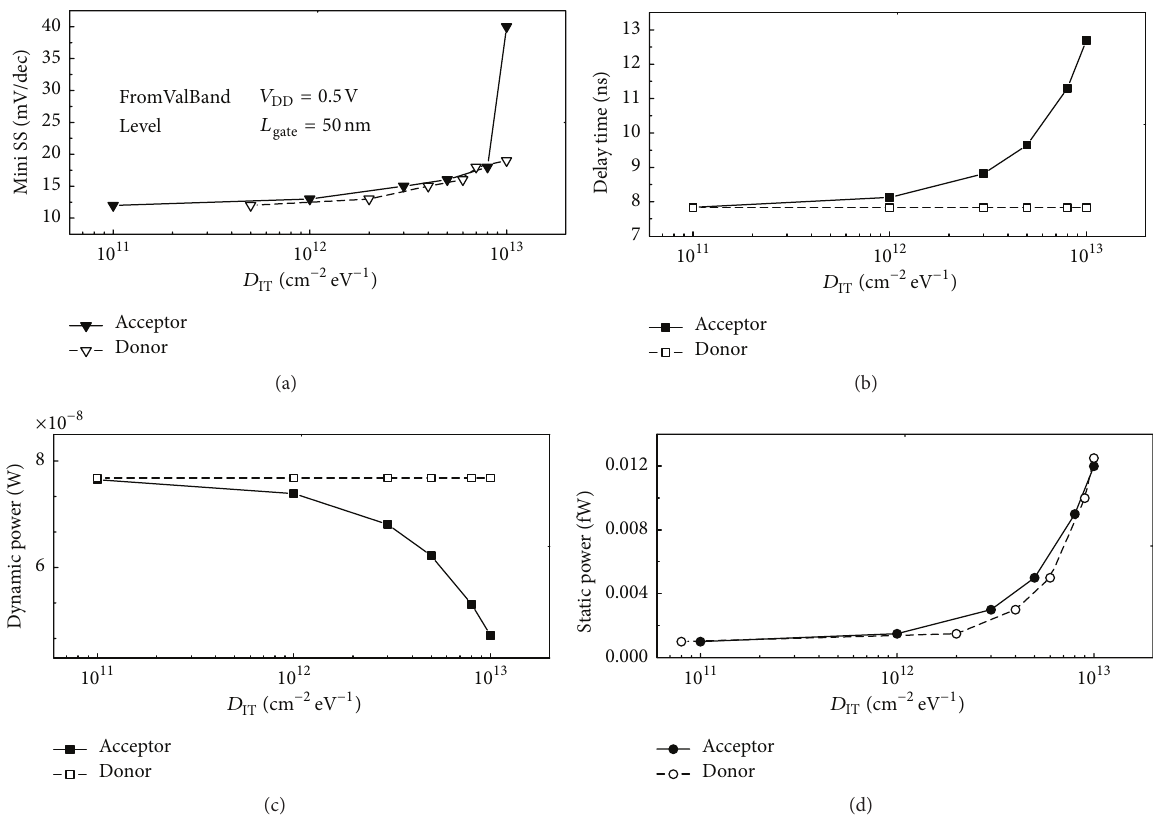
Figure 10: (a) The calculated mini SS, (b) delay time, (c) dynamic power, and (d) static power versus ITs density at valence band. Delay time 𝑉 /𝐼 𝜏 is given by 𝐶 . The donor-type ITs need more energy in static state than the acceptor-type 𝐿 DD on